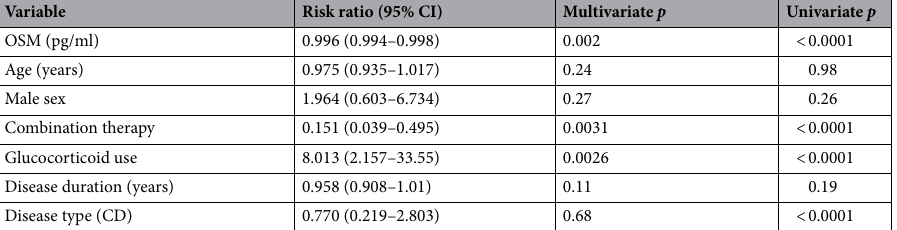
Disease type Table 5. Multiple variable regression for the effect on clinical remission at 1-year on anti-TNF therapy. Oncostatin-M, OSM; picogram, pg; kilogram, kg; Crohn’s disease, CD; confidence interval, CI; tumor necrosis factor-α, TNF.